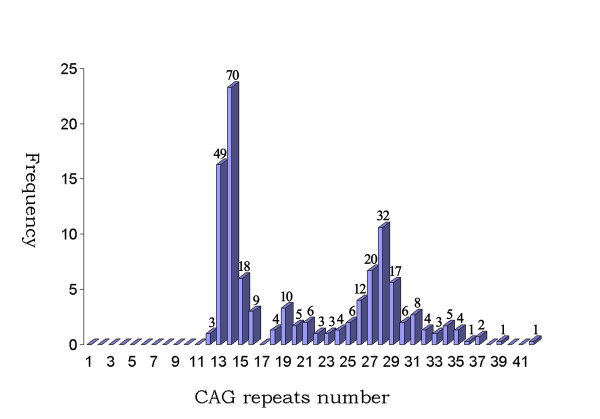
Distribution of the CAG repeats in 300 ANs from 150 healthy Chinese individuals. The numbers upon the column indicate the number of allele.